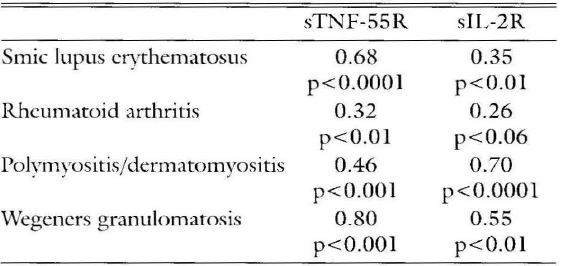
Table 6. Spearman rank coefficients (rs) of correlation be tween neopterin and sTNF-55R and sIL-2R concen n'ations in patients with autoimmune rheumatic